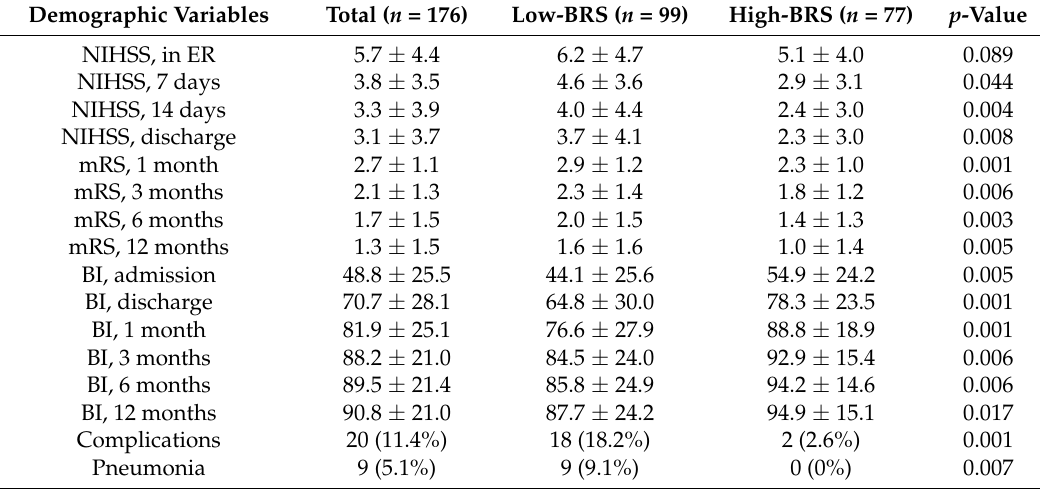
Table 2. Neurological and functional outcomes in all patients and low- and high-BRS groups.